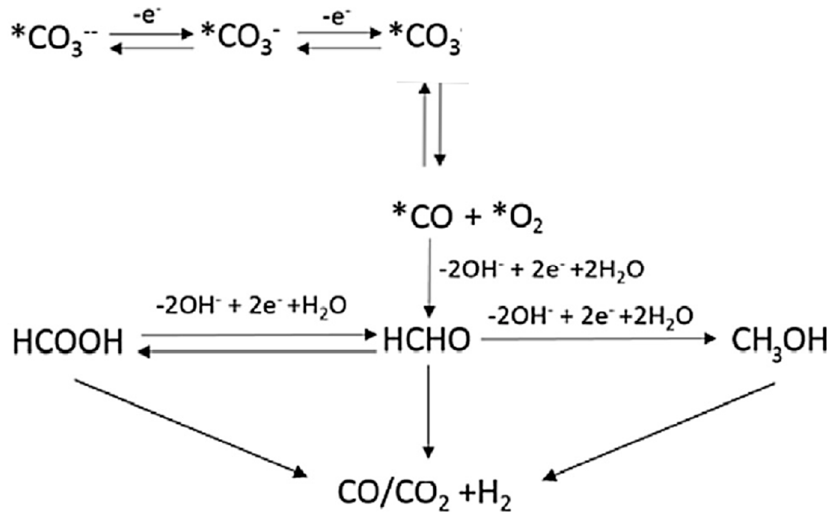
Figure 5. Influence of pH over productivity. Reaction conditions: 0.5 g L − 1 of P25, 1.66 g L − 1 HS.